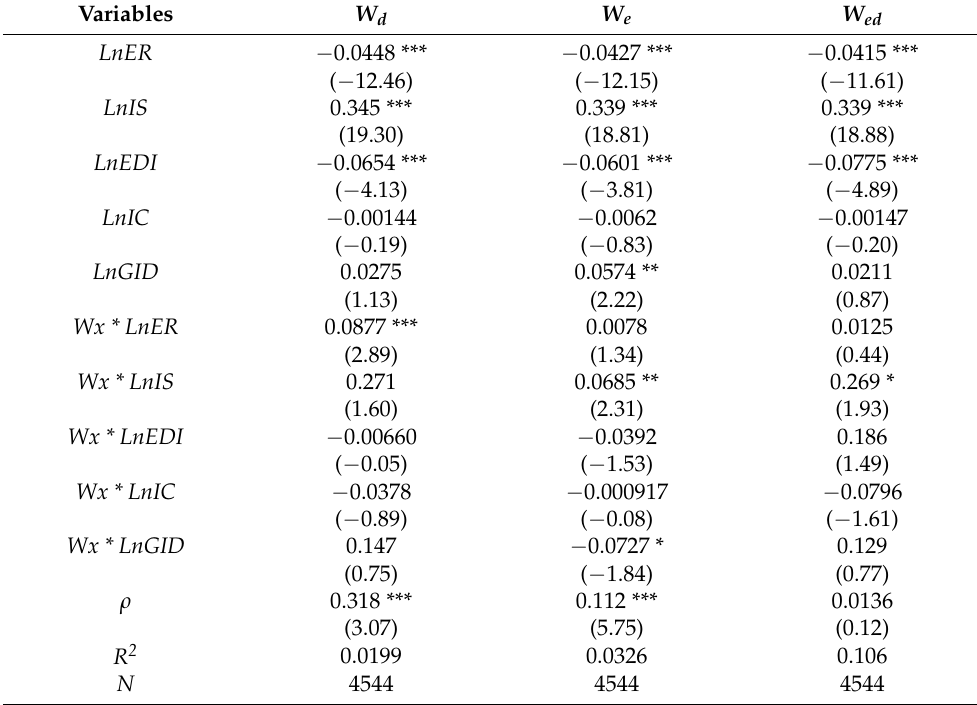
Table 4. Estimation results of the